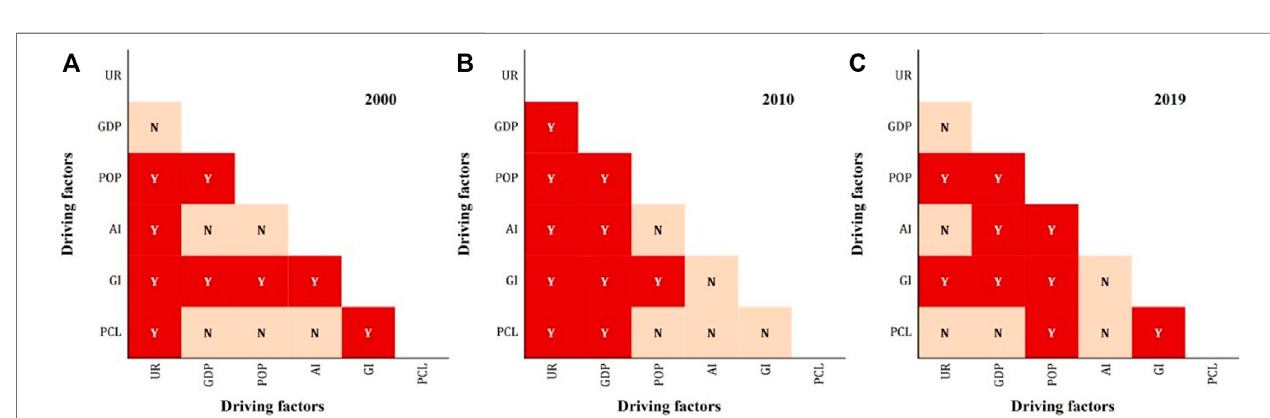
FIGURE8| Theecologicaldetectorresultsfordrivingfactorsin2000 (A) ,2010 (B) ,2019 (C) (UR:urbanizationrate,GDP:grossdomesticproductpercapita,POP: population density, AI: agricultural input, GI: grazing intensity, PCL: proportion of construction land).